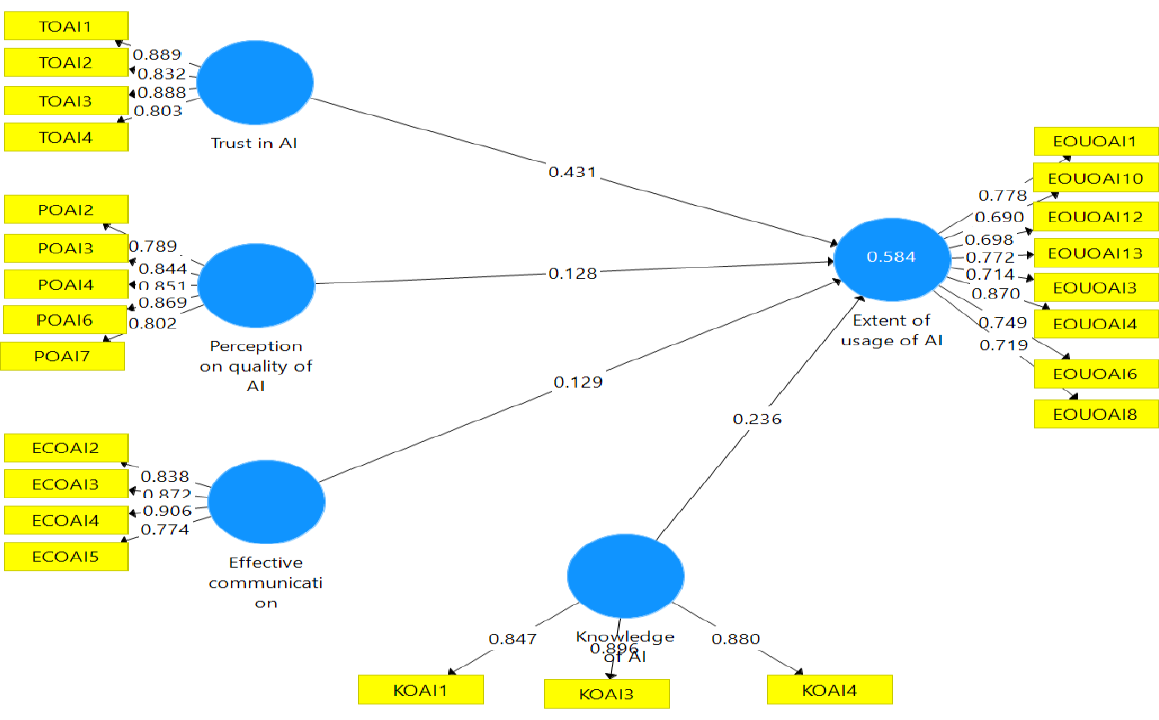
Figure 2: Assessment of PLS-SEM Structural